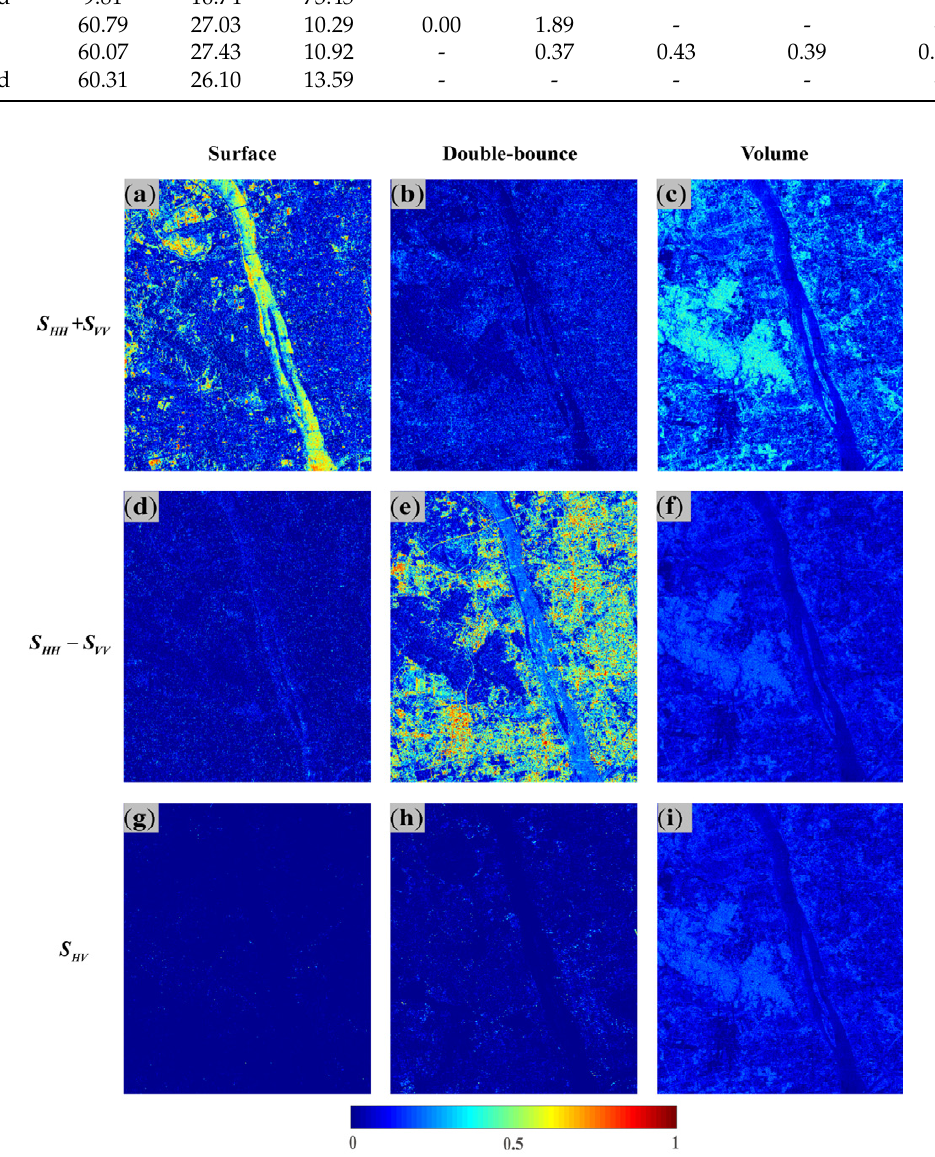
Figure 4. The ratio of the scattering power allocated to the different polarization channels of different scattering mechanisms to the total power. From left to right are the surface, double-bounce, and volume scattering. From top to bottom are the S HH + S VV , S HH − S VV , and S HV polarizations. ( a – c ) Power distribution ratio derived with 5XD; ( d – f ) Power distribution ratio derived with 7SD; ( g – i ) Power distribution ratio derived with the proposed decomposition.